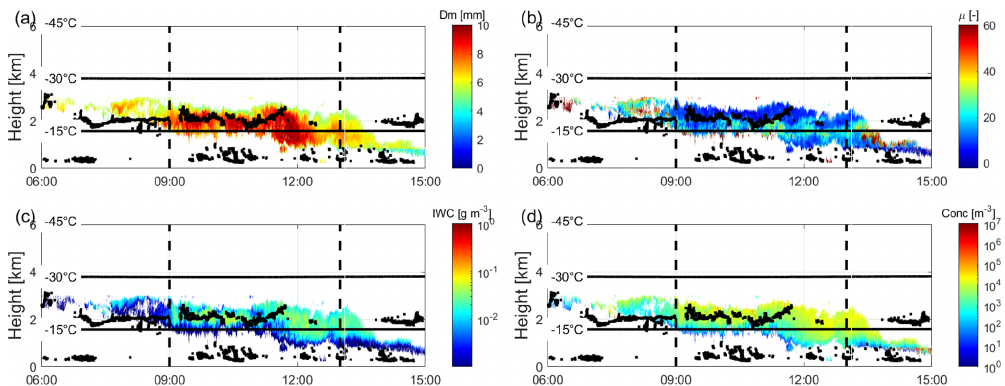
Figure 10. Time–height cross section of the retrieved (a) D m , (b) µ , (c) IWC and (d) N i when using the SSRGA-plates- M 0 . 016 model, for all pixels where DWR Ka , W is larger than 4dB. The black dots show the location of supercooled liquid water as detected by the ARM high spectral resolution lidar.